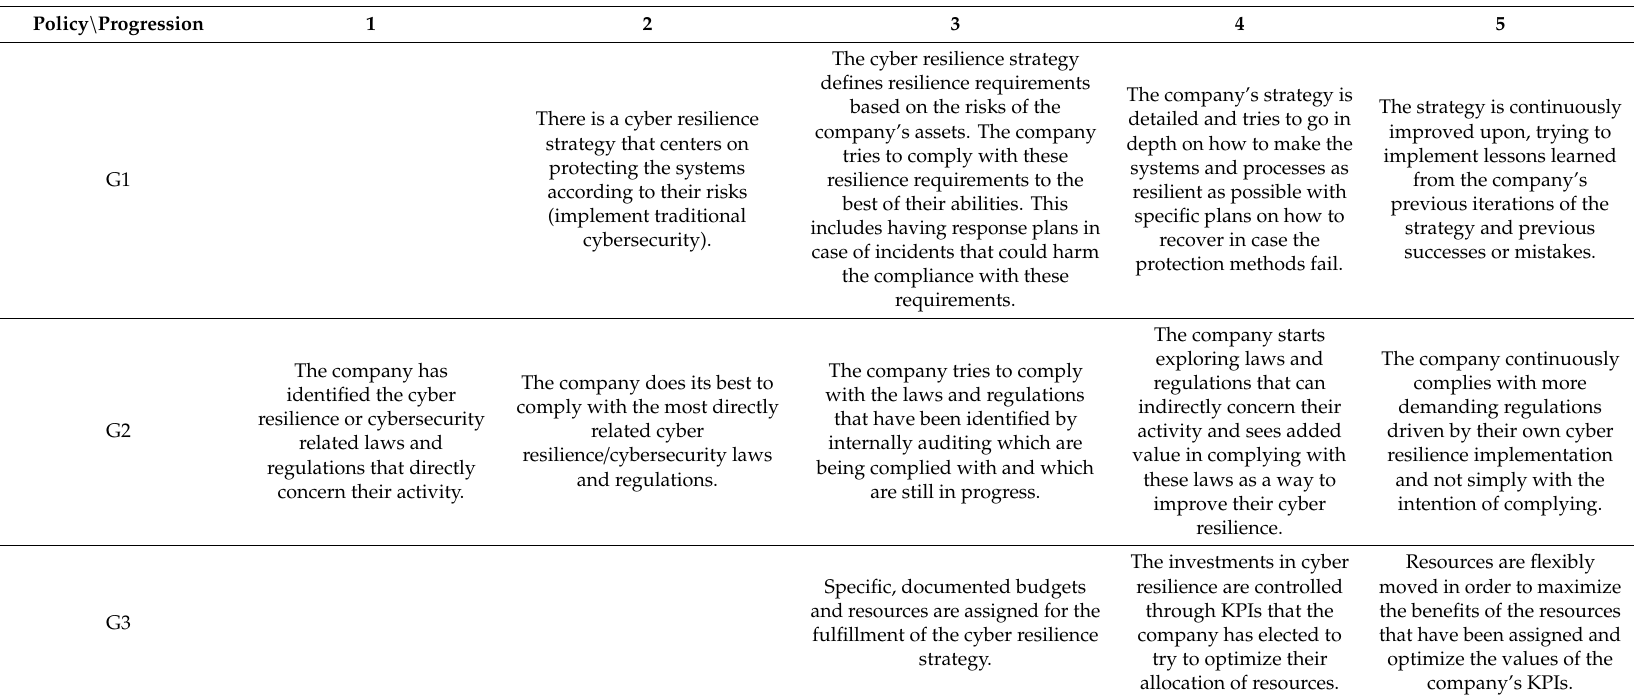
Table 4. Governance policies’ progression